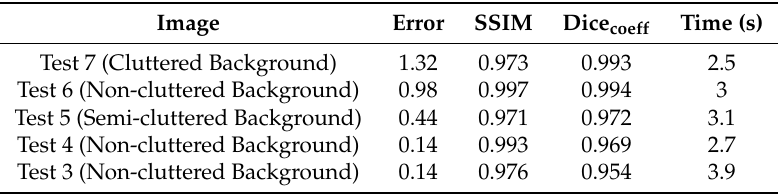
Figure 11. ( a ) Color map of IR image with semi-cluttered background, ( b ) Obtained hot spot in the power lines. After detecting power lines from visible image, histogram based thresholding on the registered IR image gives expected faults. Table 1. Obtained results on a single frame of different video sequence with cluttered and non-cluttered